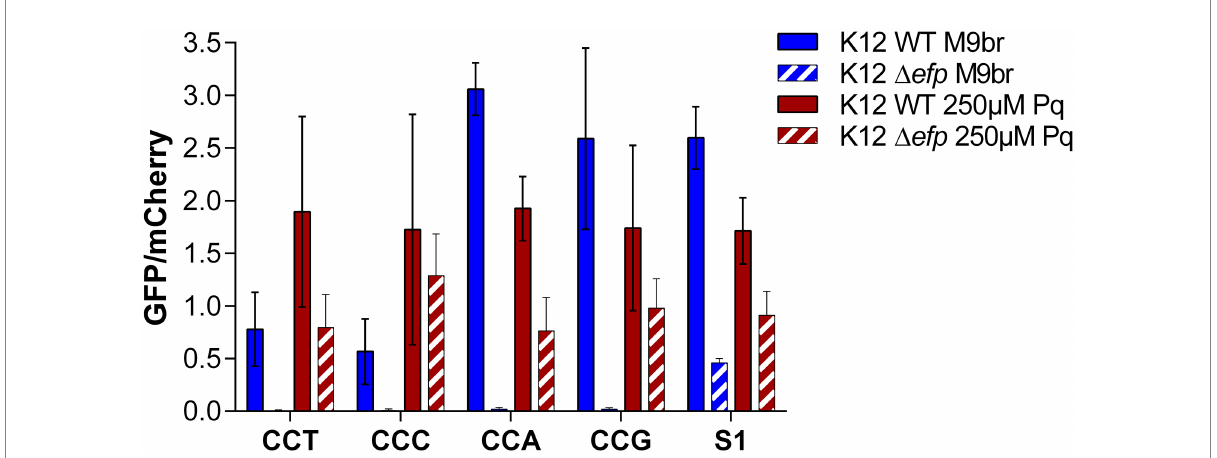
FIGURE 3 The strong inhibition of poly-proline codons translation caused by the deletion of efp does not affect translation under oxidative stress. Reporter plasmids enriched in proline codons were transformed in WT and Δ efp E. coli K-12 MG1655. GFP and mCherry fluorescence were subsequently measured under control and oxidative stress conditions. The differences in GFP production under control conditions are not observed under oxidative